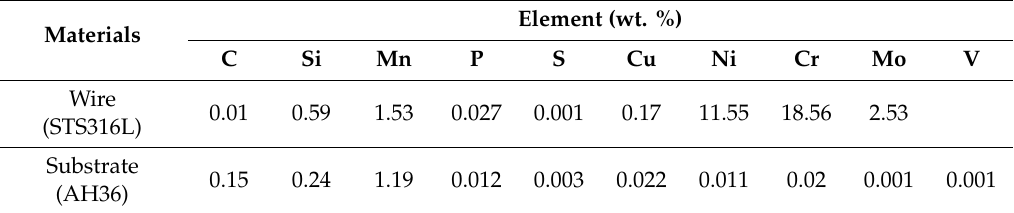
Table 1. Chemical composition of the wire (STS 316L) and substrate (AH36). Materials